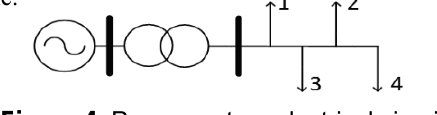
Figure 4. Power system electrical circuit